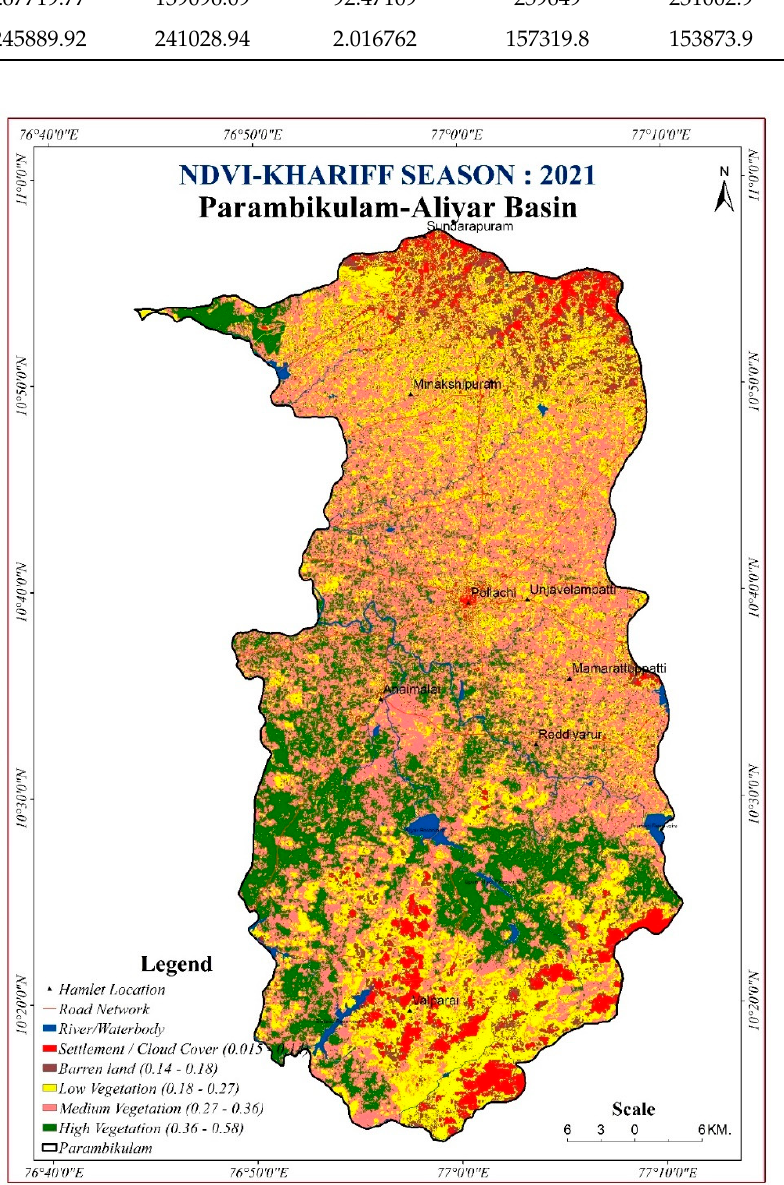
Figure 7. Mean NDVI for groundnut crop growing period, Khariff season (June to September, 2021) in PAP.